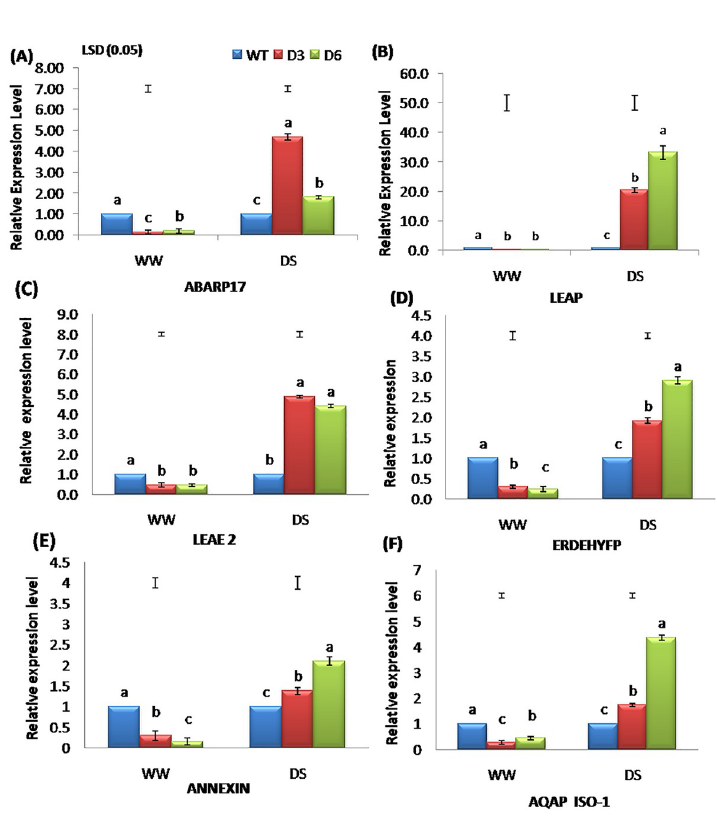
Fig 6. Relative fold change in (A) ABARP17 , (B) LEAP , (C) LEAE2 , (D) ERDEHYFP , (E) ANNEXIN , and (F) AQAP gene expressions in two selected AtDREB1A transgenic peanut lines at WW and after 25 days of DS imposition.